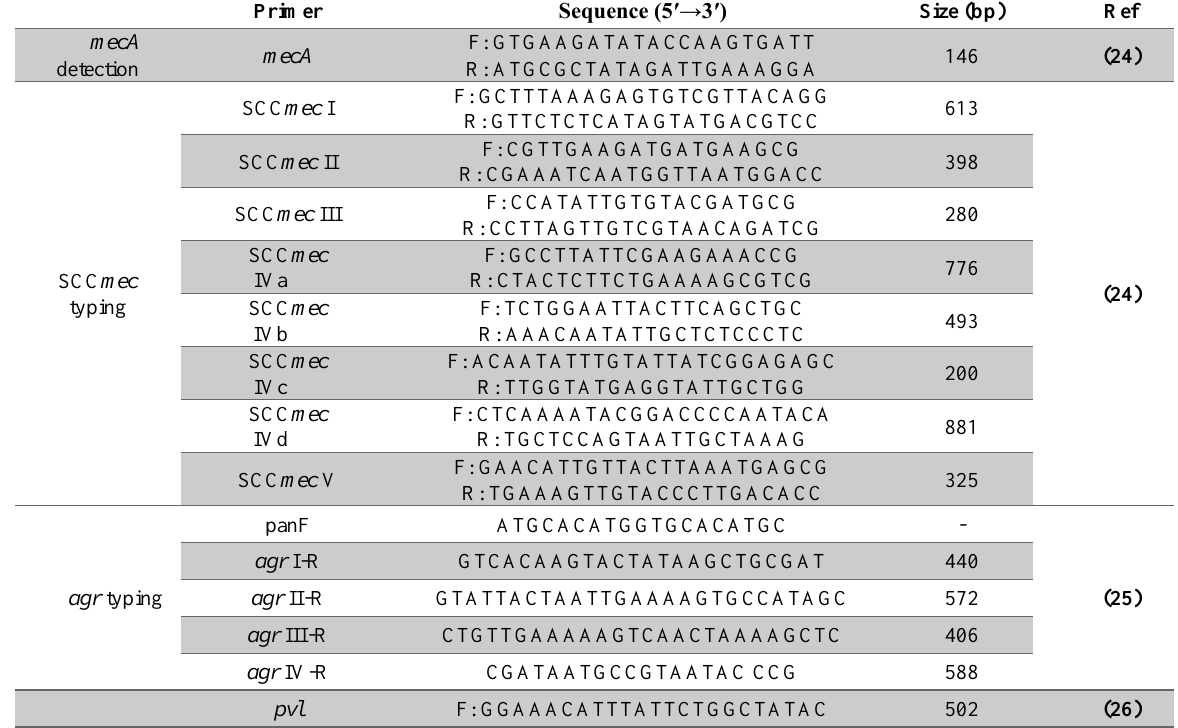
Table1. The list of primers sequences for mecA, pvl , tsst-1, hla-α, and psmα genes detection, SCC mec and agr typing and PCR products